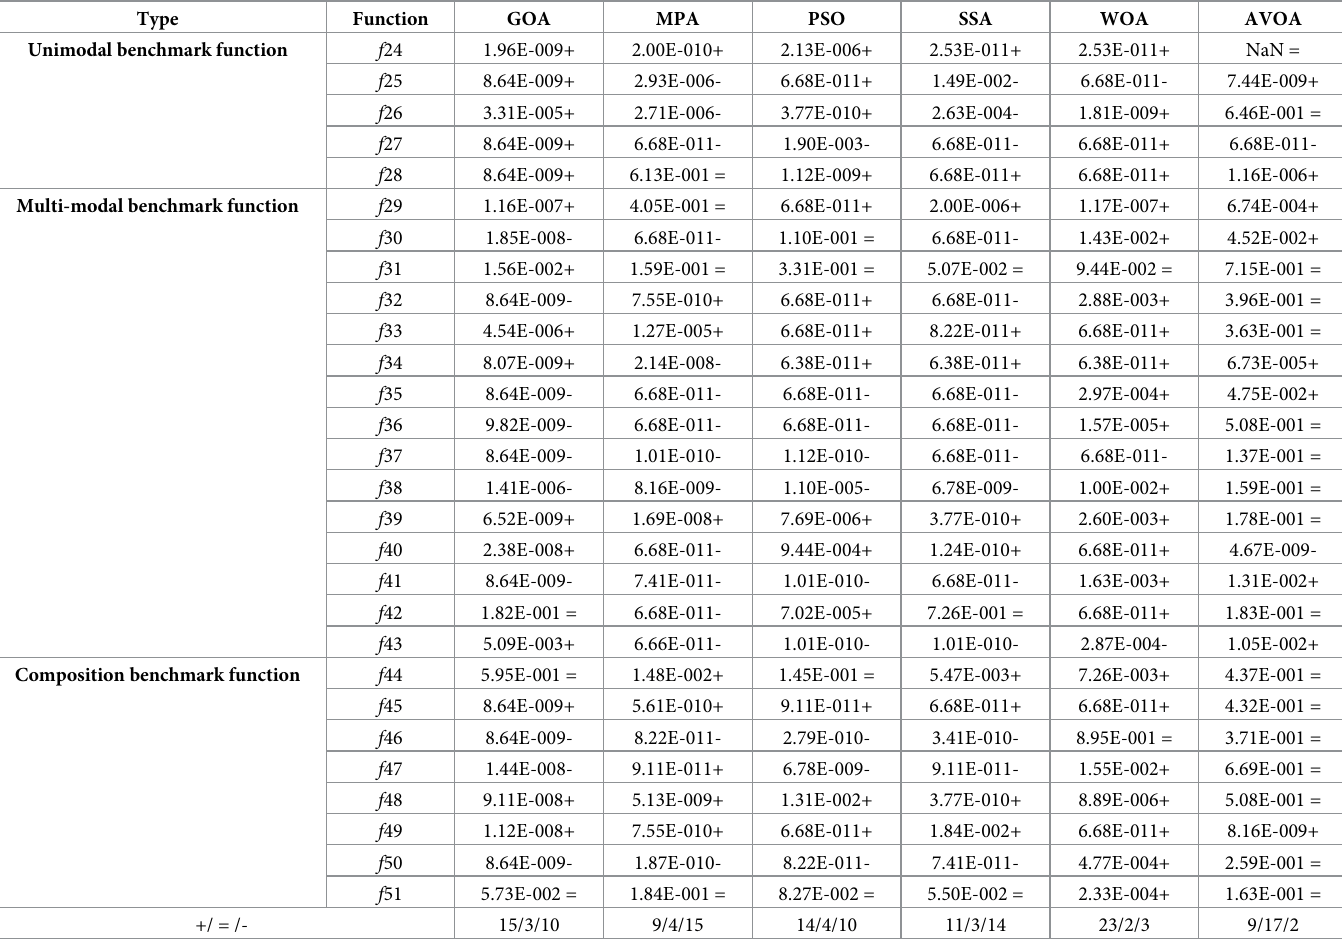
Table 11. The results Wilcoxon rank-sum statistical test with 5% among TAVOA and the 6 compared algorithms on the 28 CEC 2013 benchmark functions.